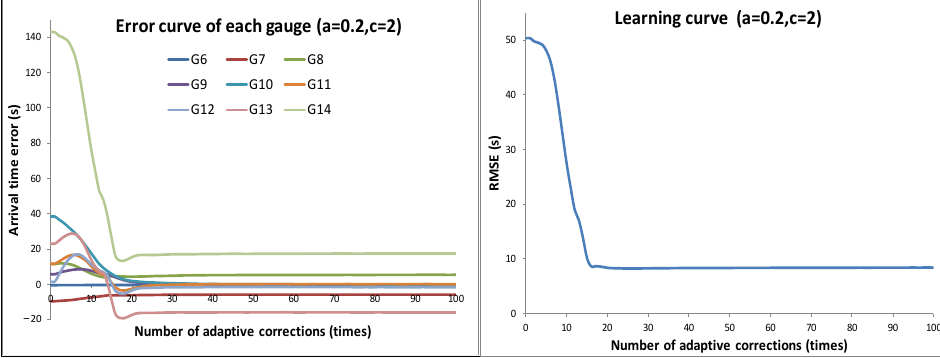
Figure 12. Error curve and learning curve of each gauge in logic-B ( a = 0.2, c =